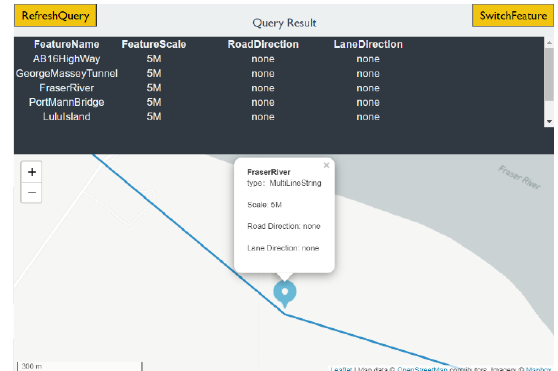
Figure 8 . Results of finding spatial objects that are available at 1:5M resolutions.